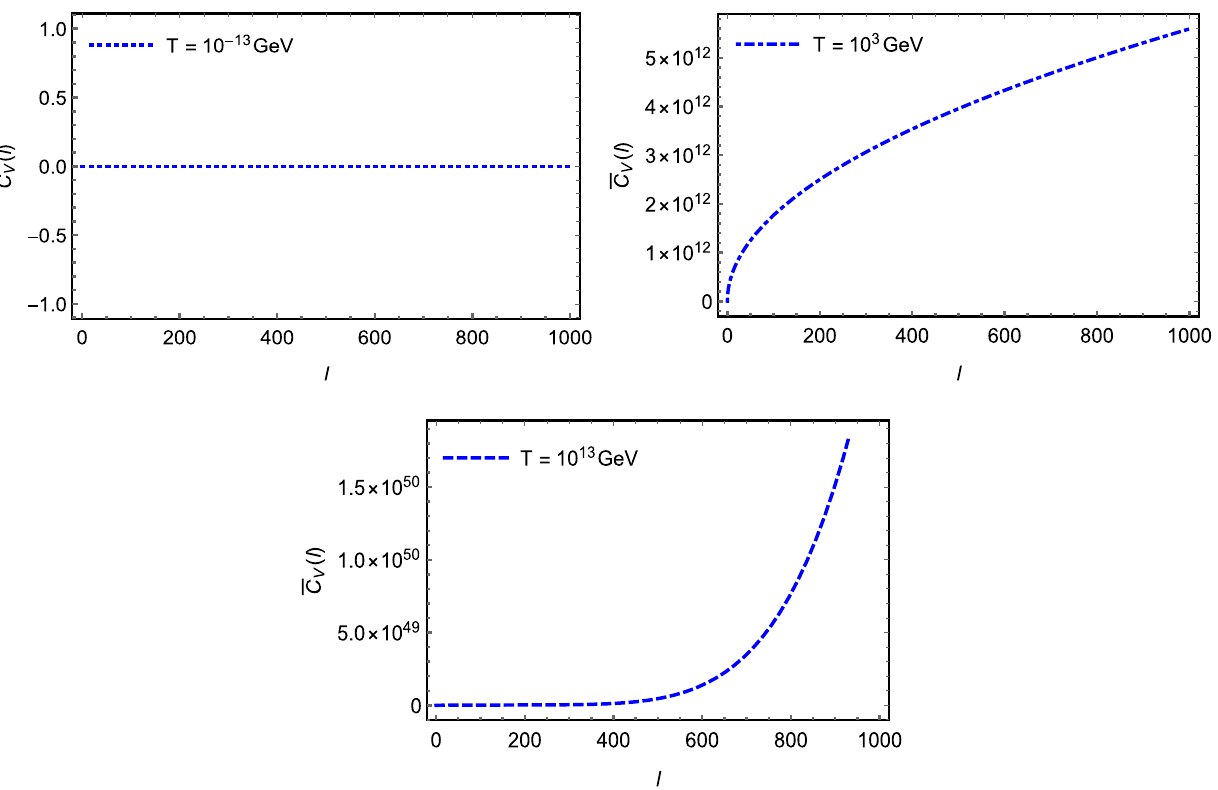
Fig. 12 The figure shows the modification of the heat capacity ¯ C V as a function of l ( whose dimension is m · kg − 1 / 2 · s − 1 ) considering the